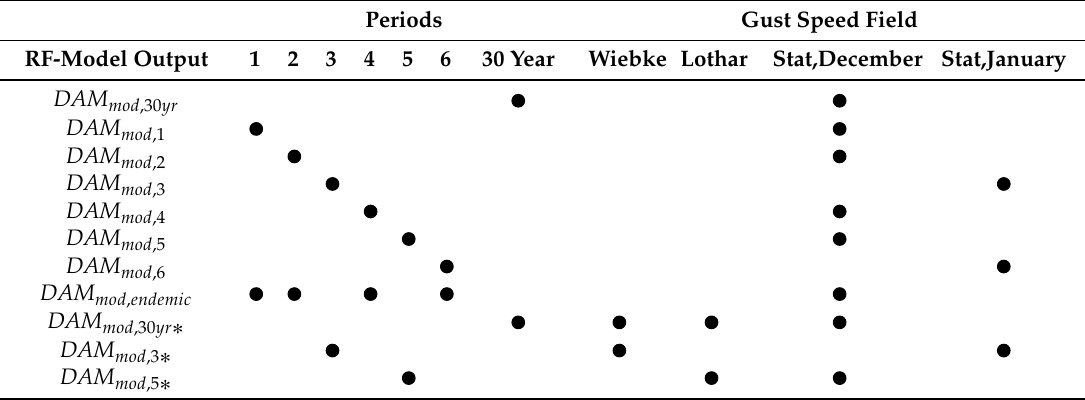
Table 2. Summary of random forests (RF) model outputs for different periods (1–6, 30 year) and gust speed fields used to build the